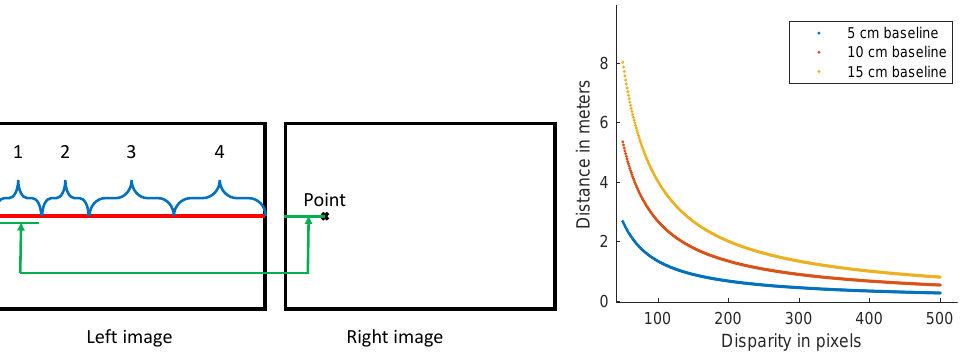
Figure 3. Illustration of stereo disparity ranges ( left ): (1) impossible due to stereo constraint; (2) impossible in deep underwater imaging due to light fading at far distances; (3) possible disparity; (4) the point is very close, so it becomes overexposed, undetectable, or out of focus. At ( right ), the disparity evaluation in pixels as a function of distance (in meters) to the camera for the 3 available baseline distances.